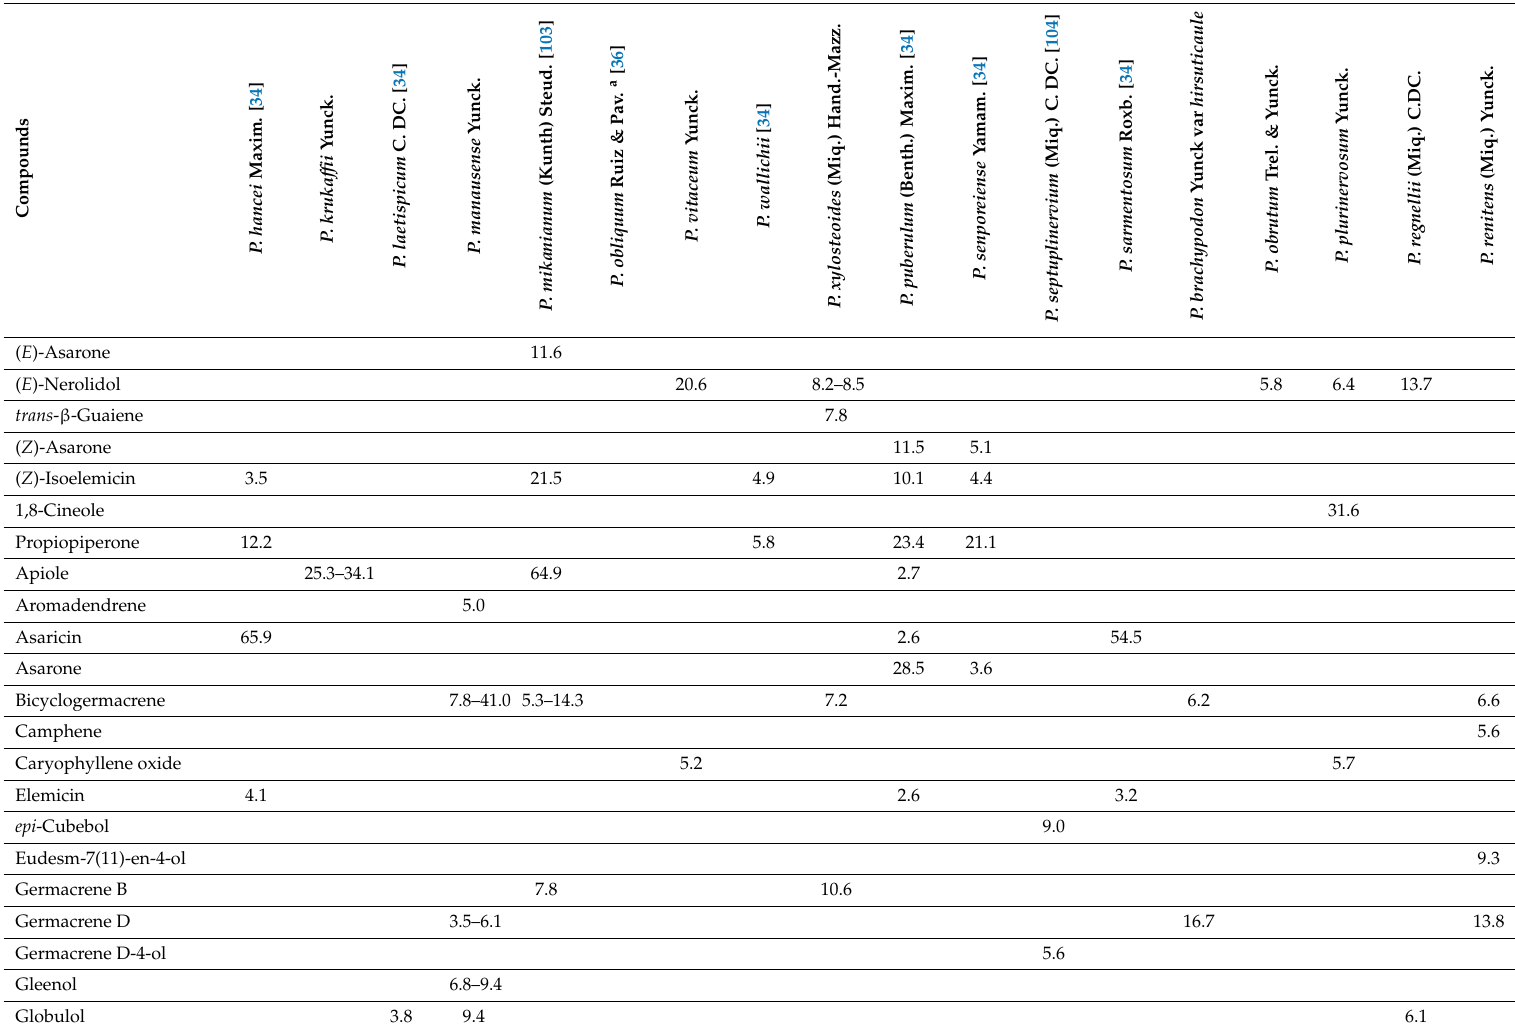
Table 27. Chemical compositions (%) of aerial parts essential oils from miscellaneous Piper species, part